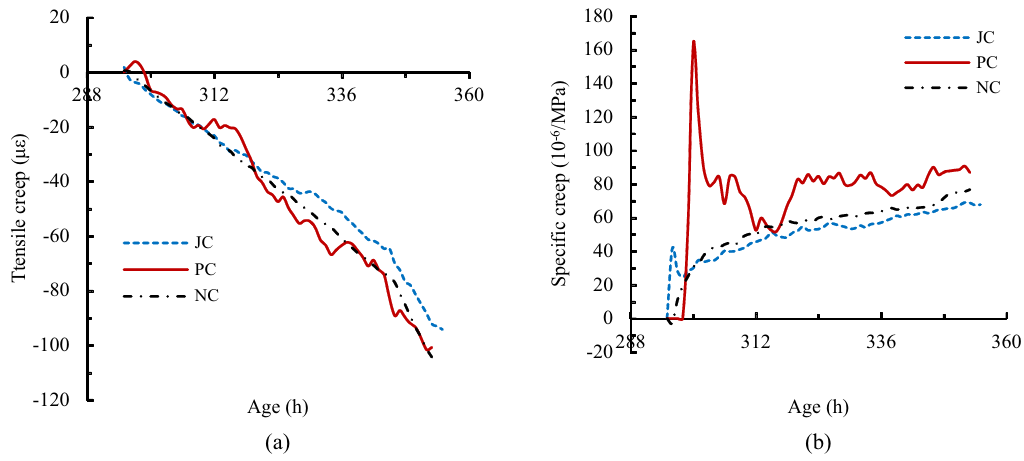
Figure 8: ( a ) Tensile creep and ( b ) speci fi c creep of three concretes under CTC mode.